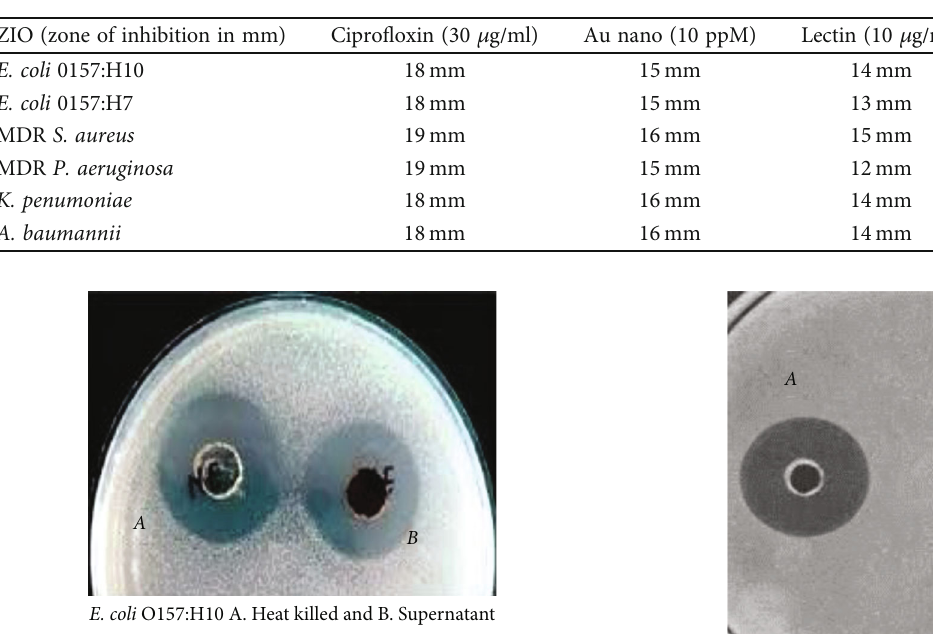
Table 1: Zone of inhibition of pathogens against lectin and Au nanoparticle.